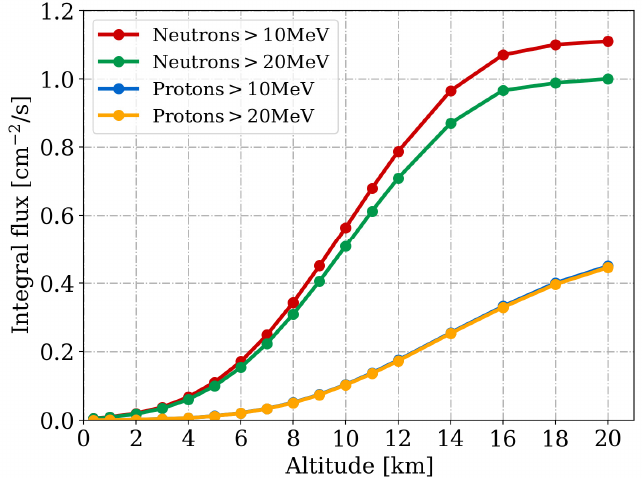
Figure 3. Integral neutron and proton fluxes, above 10 MeV and 20 MeV, for different altitudes above Geneva.